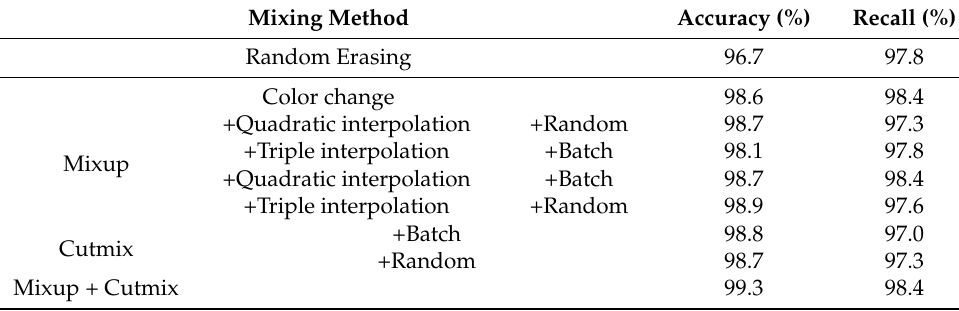
Table 3. Results of data enhancement experiments. Figure 7. Model training results. ( a ) Accuracy curve, ( b ) Loss curve.